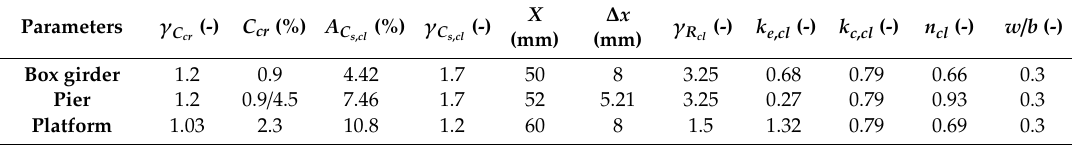
Table 11. Parameters used in the revised DuraCrete model in the marine